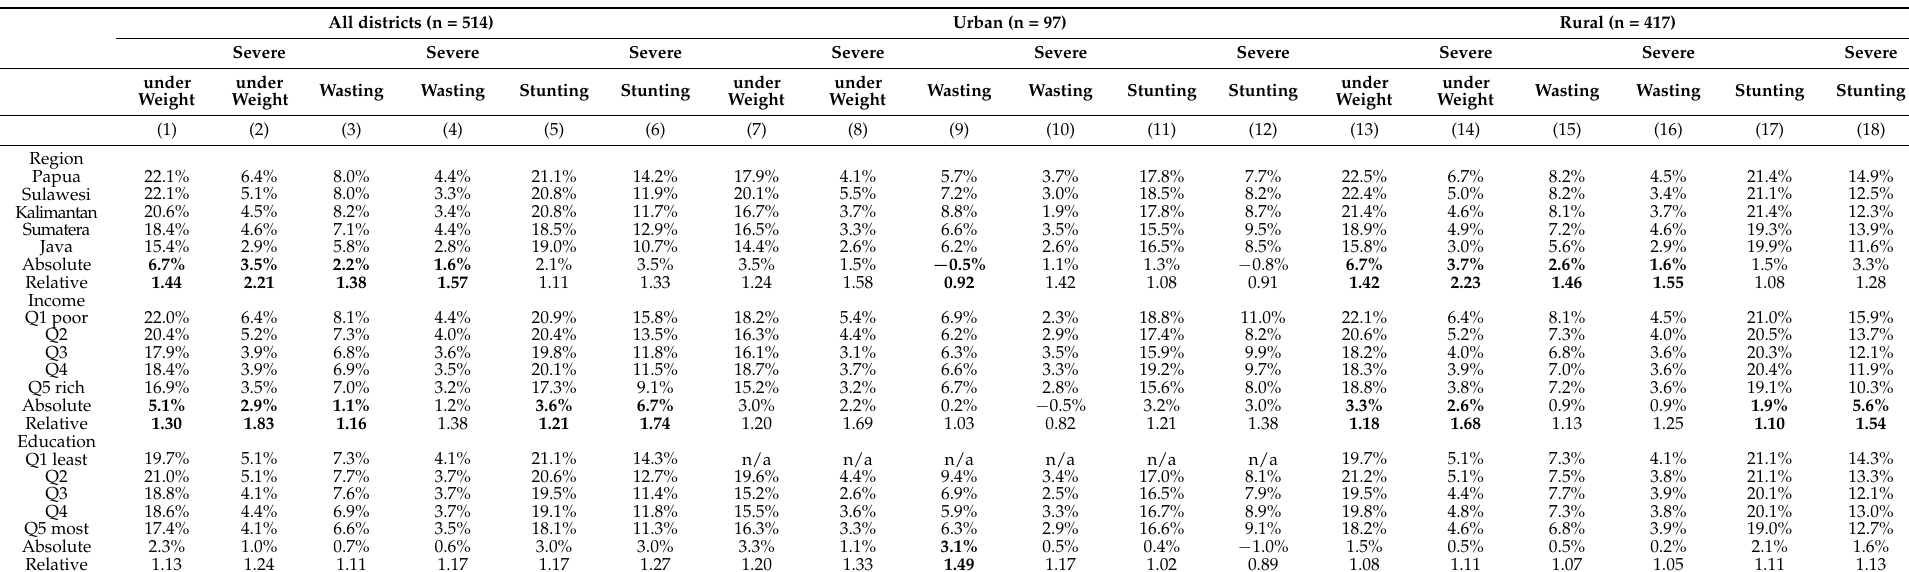
Table A2. Geographic and socioeconomic disparity in child